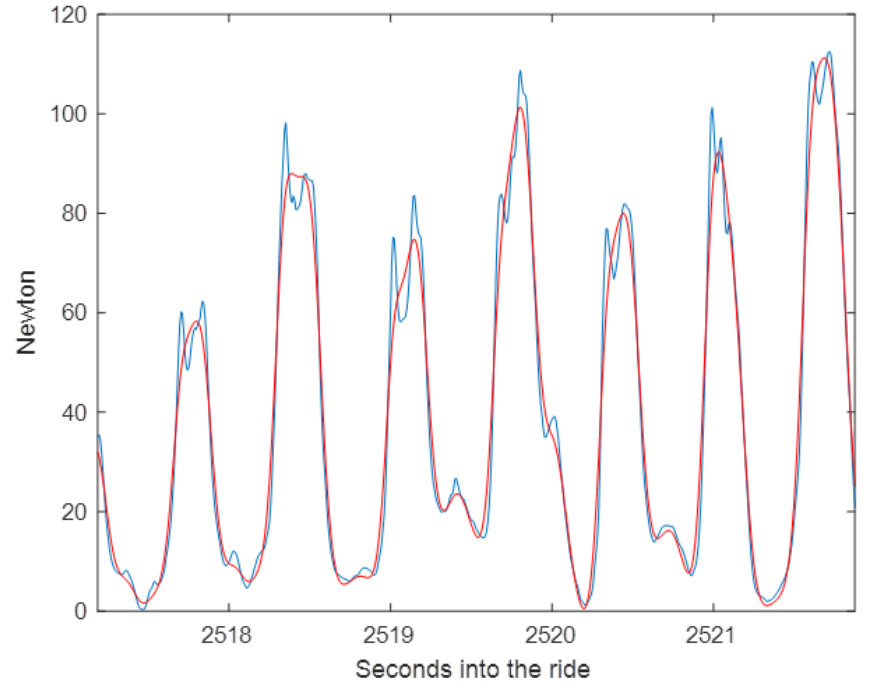
Figure 7. Rein tension data from the left rein in canter, sampled at 128 Hz. Original trace in blue and low-pass filtered trace in red (filter of order 2 and cutoff frequency 5 Hz). Note the loss and attenuation of the peaks.